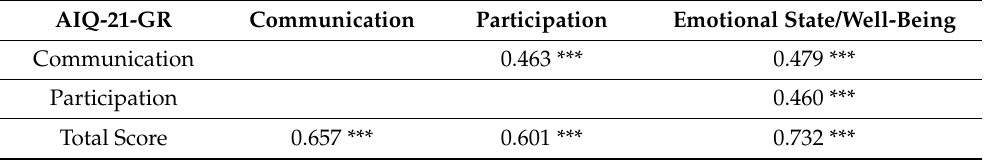
Table 6. Spearman rho correlations between AIQ-21-GR total score and the three domains of the tool. AIQ-21-GR Communication Participation Emotional State/Well-Being Communication 0.463 *** 0.479 *** Participation 0.460 *** Total Score 0.657 *** 0.601 *** 0.732 ***